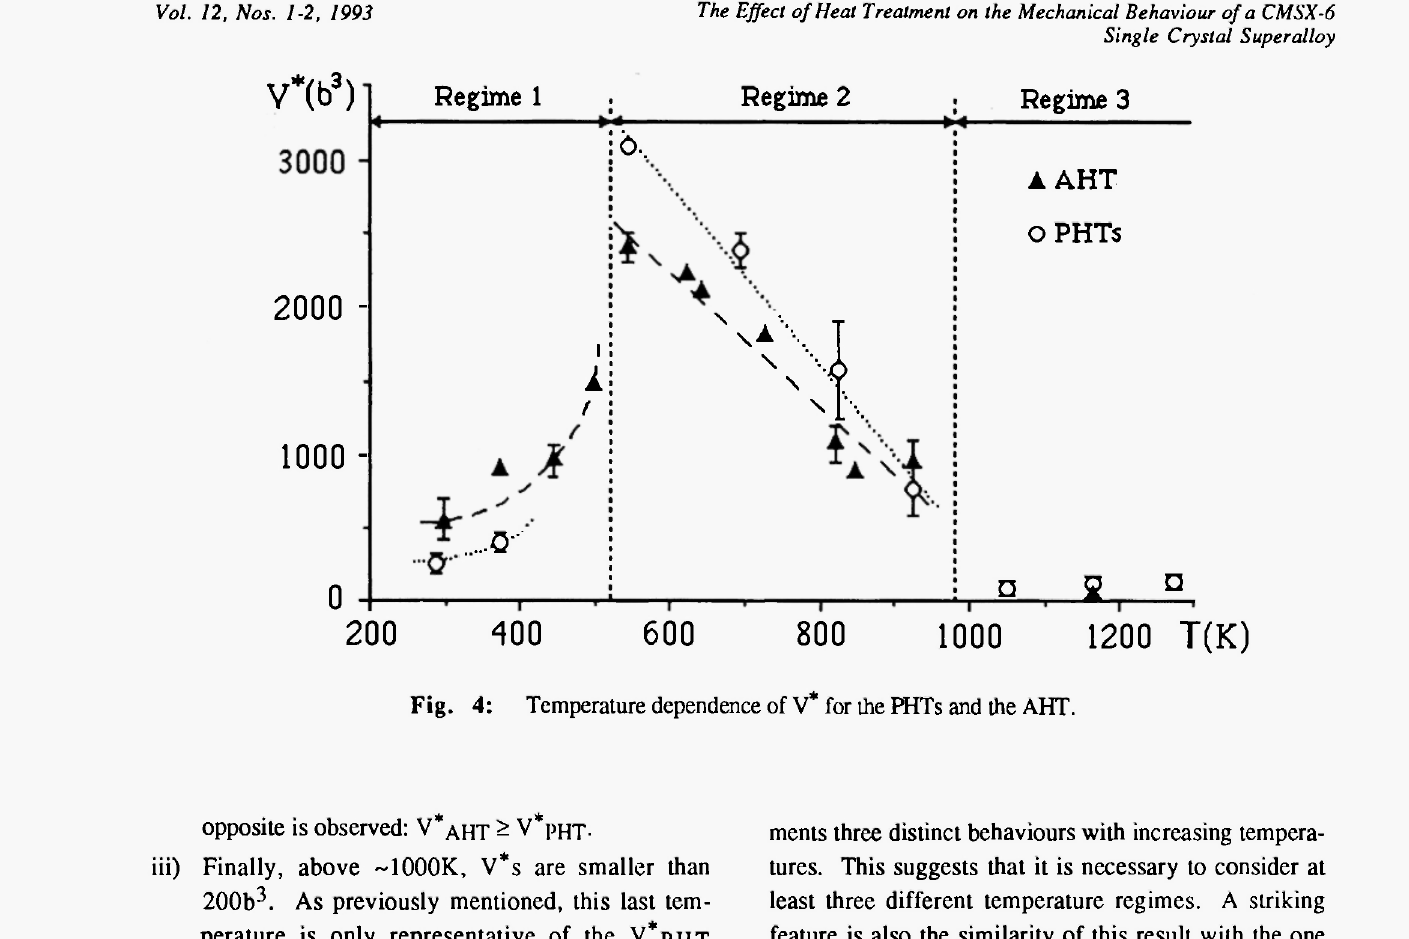
Fig. 4: Temperature dependence of V* for the PHTs and the